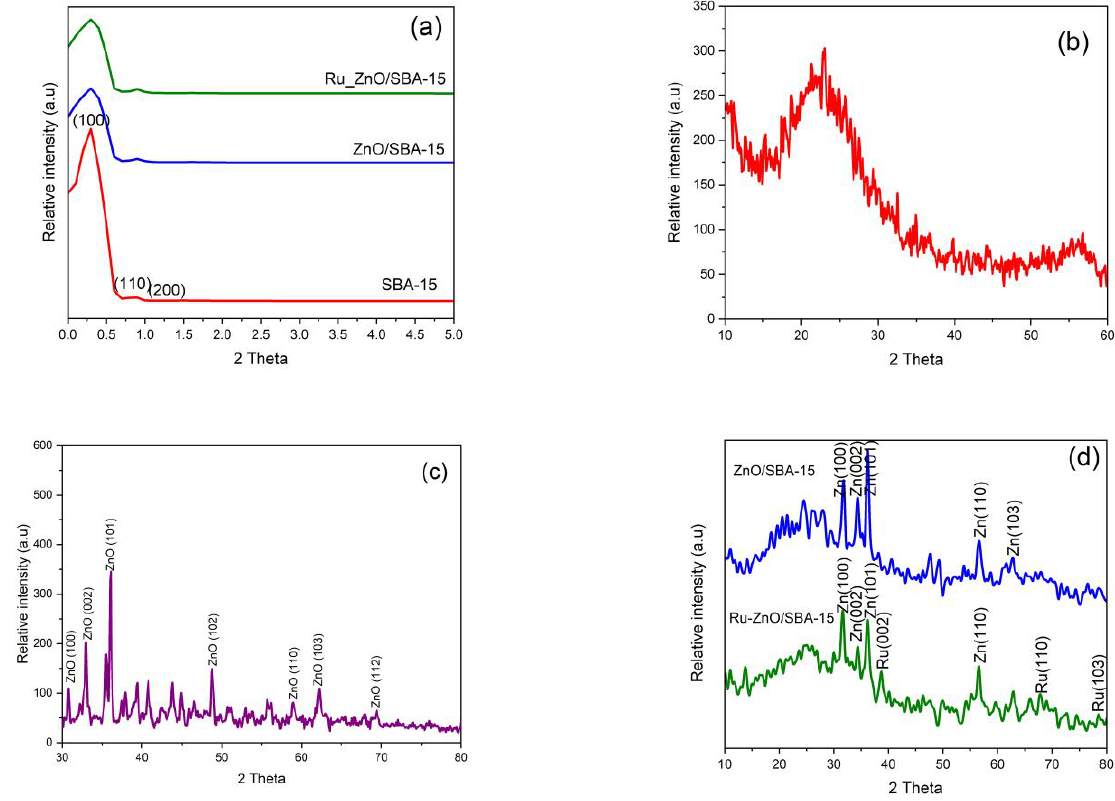
Figure 5. SA-XRD patterns for ( a ) as-prepared amorphous SBA-15 support, ZnO/SBA-15 and Ru-ZnO/SBA-15 composites; WA-XRD patterns for ( b ) SBA-15; ( c ) ZnO; ( d ) ZnO/SBA-15 and Ru-ZnO/SBA-15 composites.